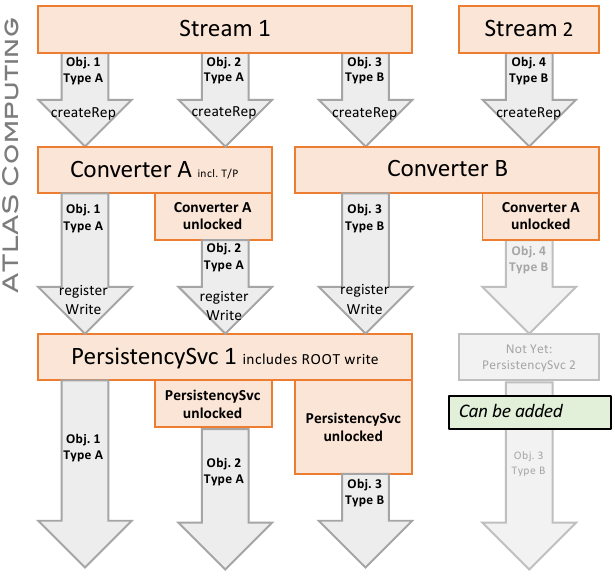
Figure 2. Opportunities for parallelism within the conversion